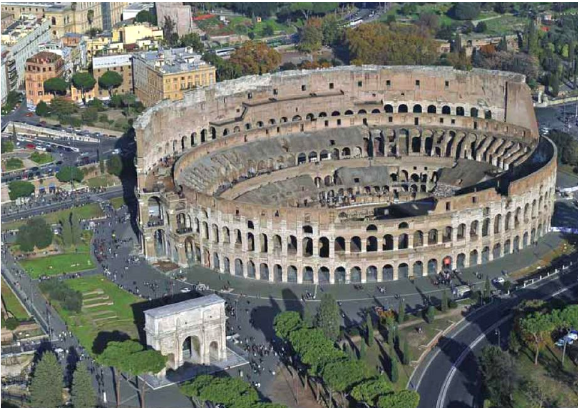
Figure 1. View of the Amphitheatrum Flavium with the northern